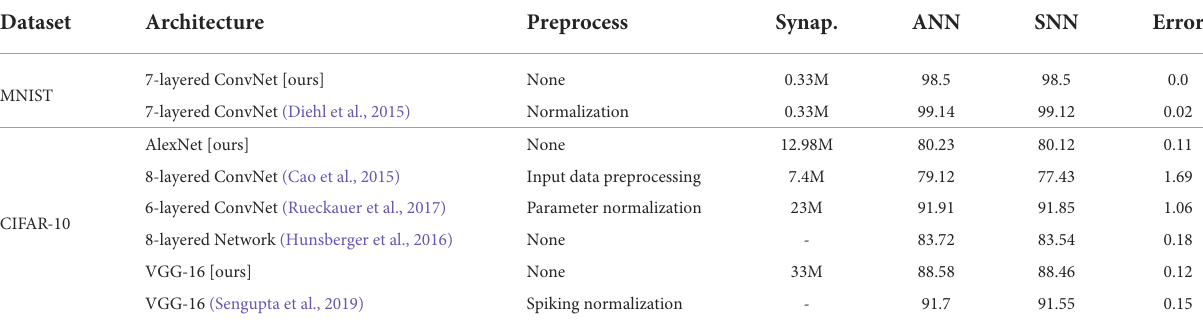
TABLE 6 Classification error rate on MNIST and CIFAR-10 dataset.